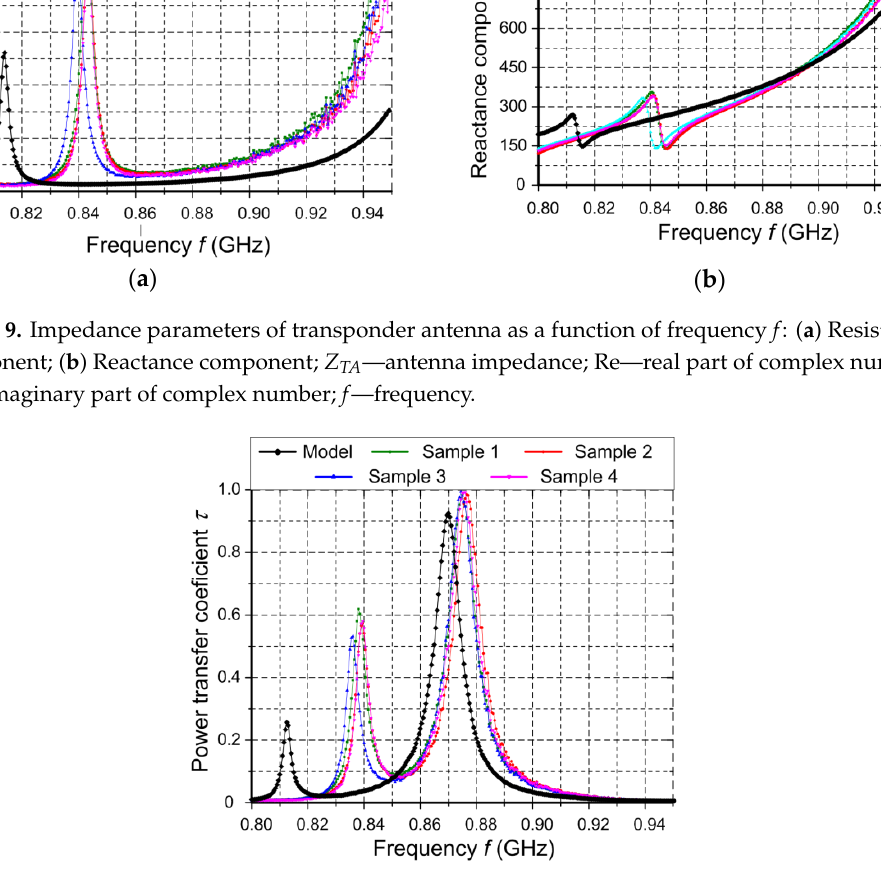
Figure 10. The coefficient of power transferring from antenna to the chip τ as a function of frequency f .